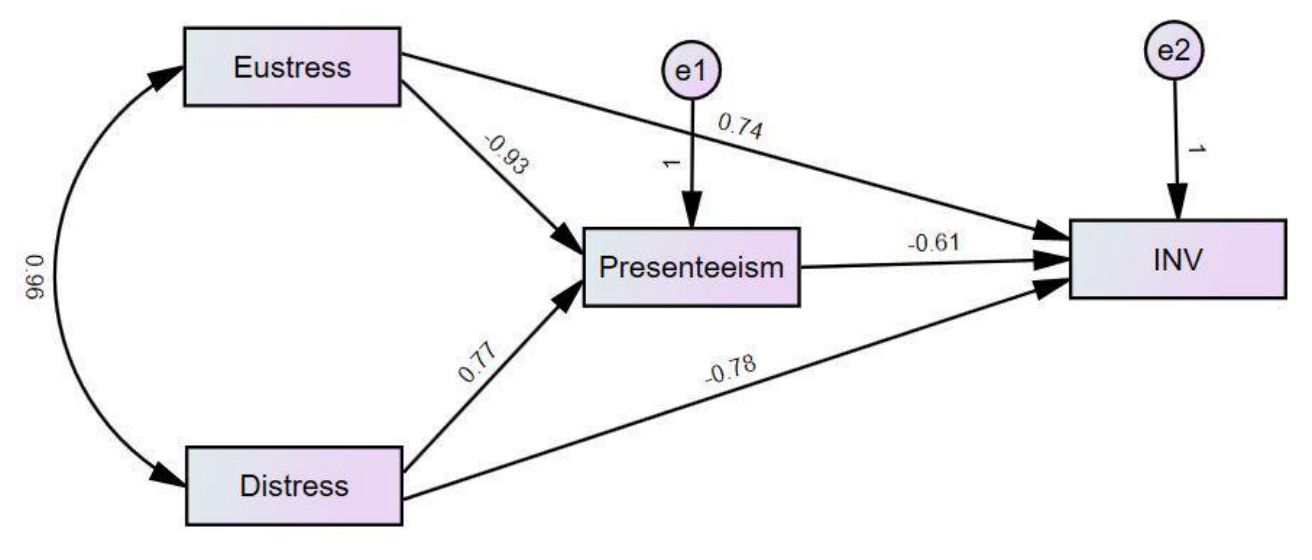
Figure 3. SEM analysis proposed model.